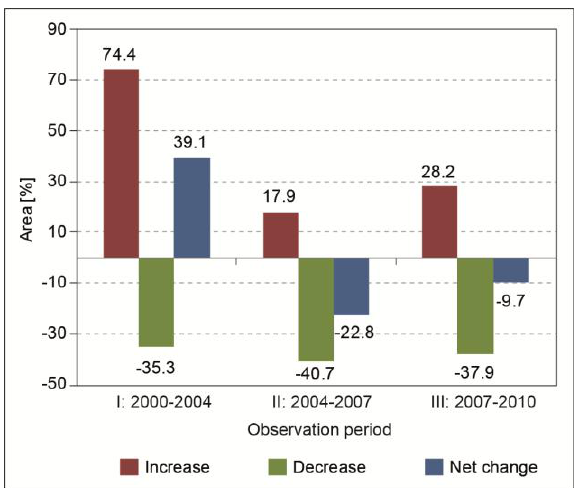
Figure 7. Differentiated consideration of quantitative